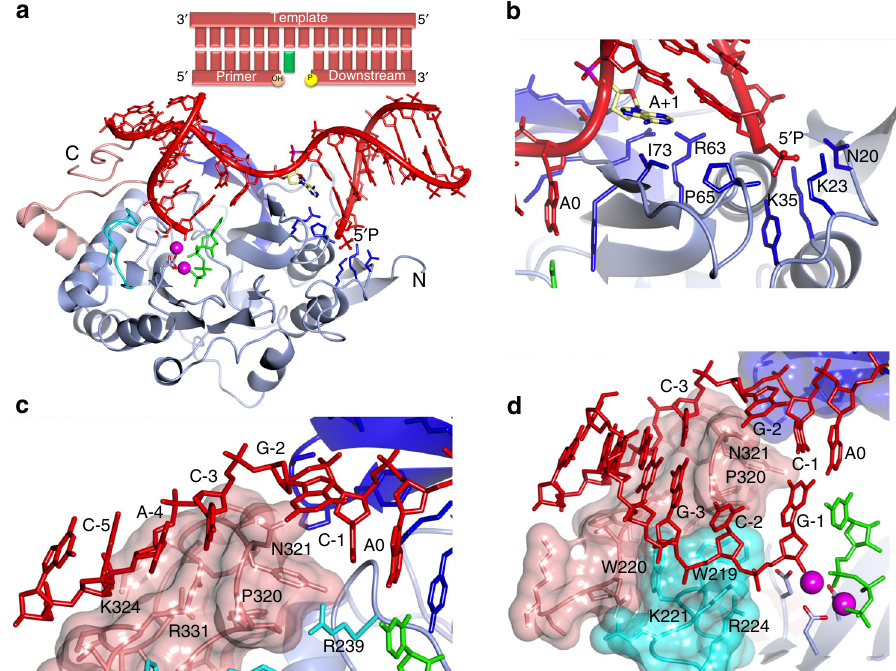
Fig. 1 Crystal structure of a ternary Prim – PolC – DNA – NTP complex. a Schematic of the 2-nt gapped DNA substrate found in the ternary complex (top panel). The bottom panel shows a ribbon-diagram representation of the Prim – PolC – DNA – NTP complex (PDBID: 6SA0). The catalytic core is coloured sky blue, with the conserved loop structures from this family coloured dark blue, cyan and pink for Loops 1 – 3, respectively. The catalytic aspartate side chains are represented with the carboxylic oxygens shown in red and bound manganese ions depicted as magenta spheres. The incoming nucleotide, rUTP (UpNHpp), is coloured green. Side chains involved in forming the 5 ′ phosphate-binding pocket are depicted in dark blue. b Molecular interactions of the N- terminal region of Prim – PolC with the 5 ′ -phosphate moiety (downstream stand) and the dsDNA/ssDNA junction. c Details of the interactions of Loop 3 with upstream template DNA. The primer strand is removed for clarity. d A view of the solvent-accessible surfaces of Loops 2 (cyan) and 3 (salmon) interacting with the upstream DNA duplex. N321 is shown to interdigitate into the DNA duplex and, with P320, cause the DNA to unpair at the − 2 position. Loop 2 supports the primer strand of the upstream